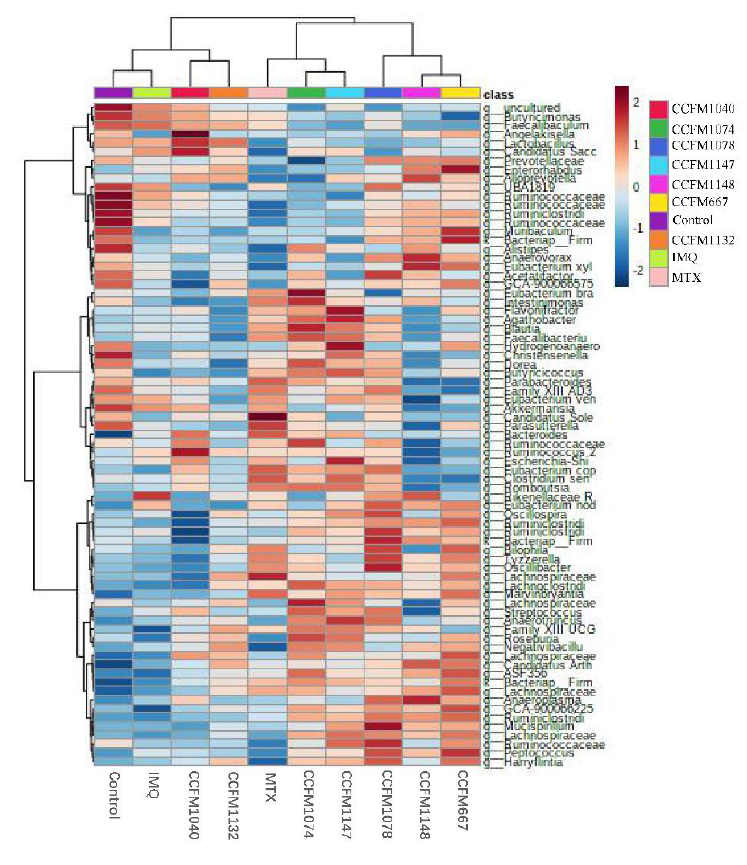
Figure 7. Clustering analysis of gut microbiota at the genus level ( n = 5/6).